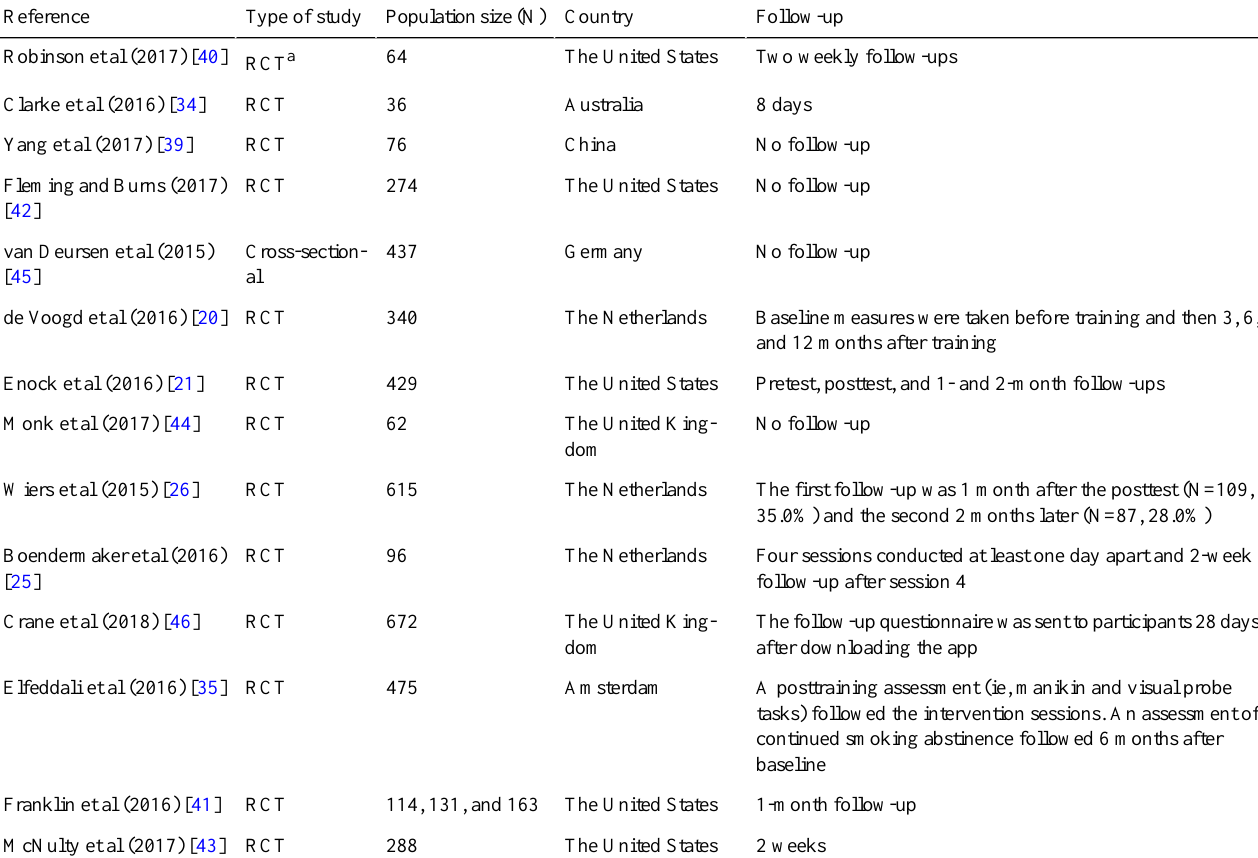
Table 1. General demographics of included studies